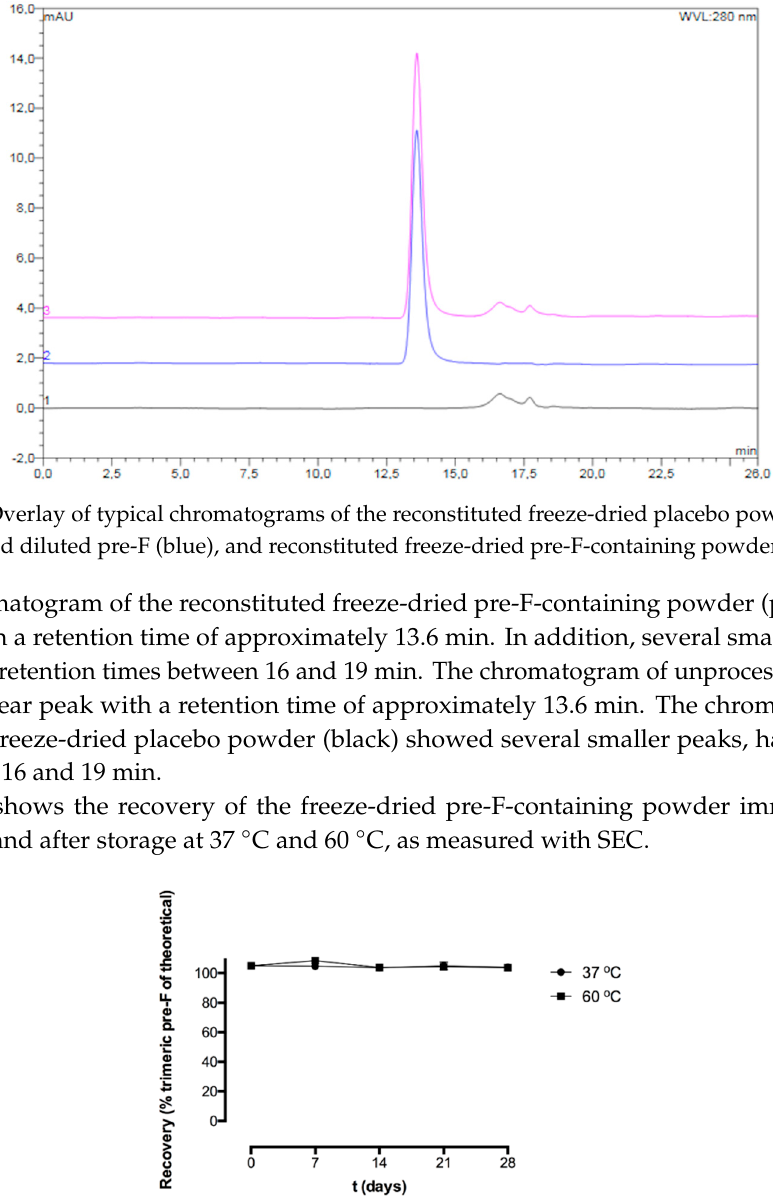
Figure 4. Recovery (% trimeric pre-F of theoretical) of the freeze-dried pre-F-containing powder formulation immediately after freeze-drying and after storage at 37 °C (circle) and 60 °C (square). For each time point, n = 3, mean and standard deviation are given.